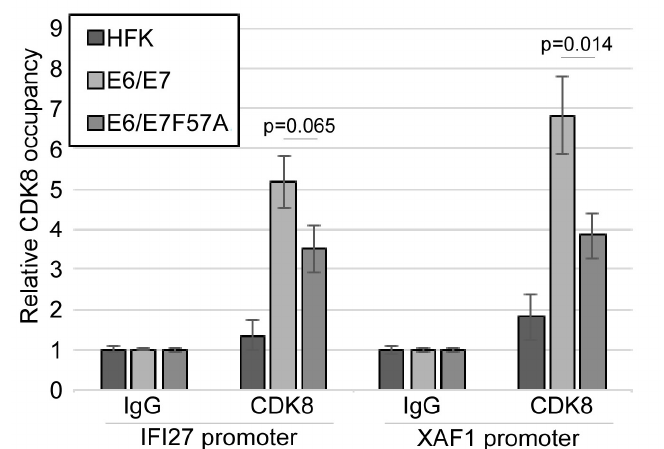
Figure 7. Chromatin immunoprecipitation of CDK8 from ISG promoters. ChIP was performed with IgG (control) or CDK8-specific antibodies using chromatin from HFK, pLXSN E6 / E7, and pLXSN E6 / E7 F57A cells. Eluted DNA from ChIP was used in a qPCR reaction with primers specific for the IFI27 and XAF1 promoters. Relative enrichment of CDK8 was determined by normalizing the CDK8 signal to IgG, with IgG samples set to 1.